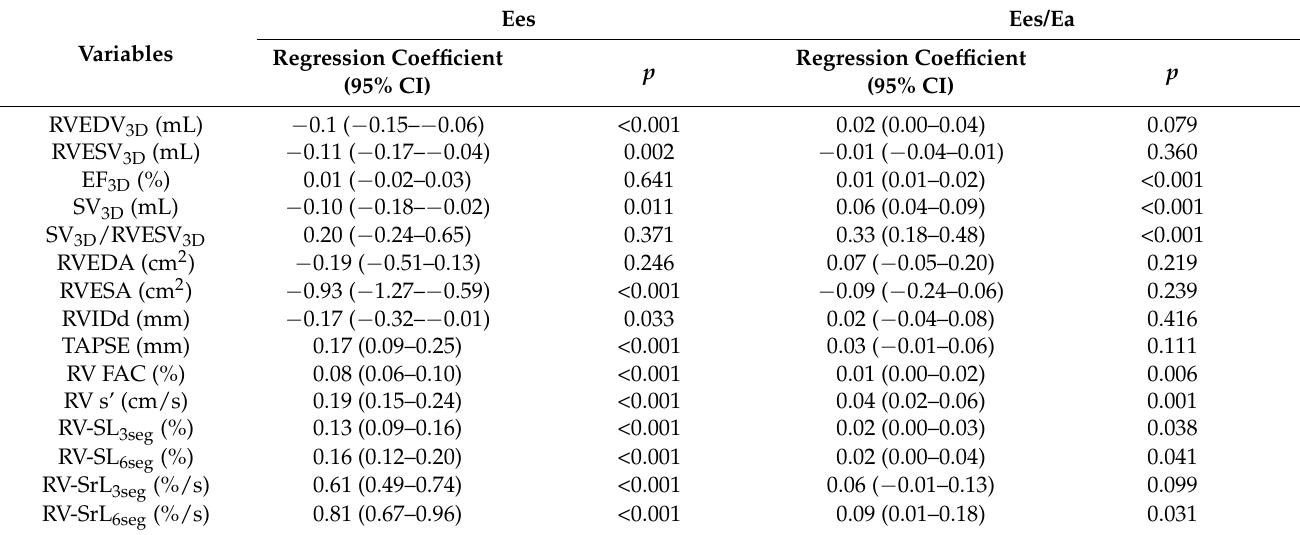
Table 3. Results of single regression analyses to estimate right heart catheterization-derived right ventricular functional